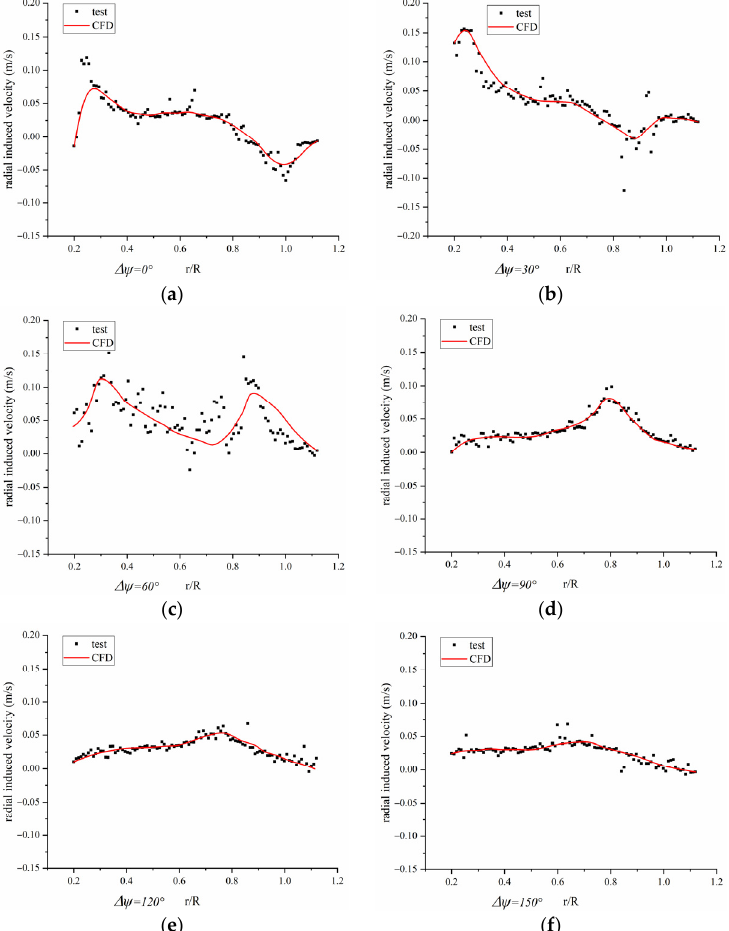
Figure 12. Radial induced velocity at 𝜓 = 180 ° .